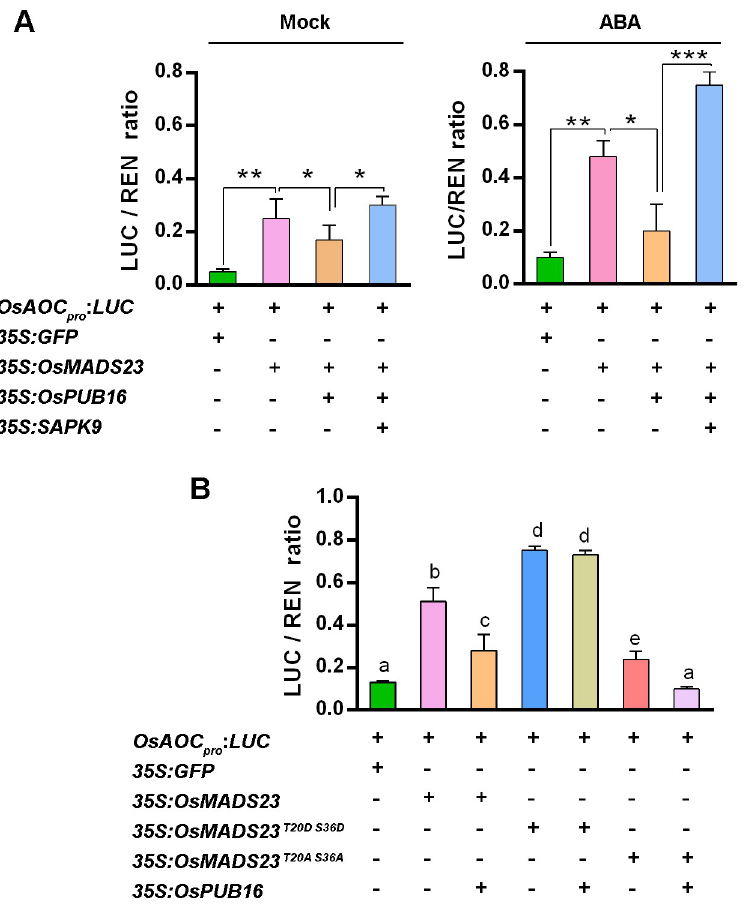
Fig 9. The influence of SAPK9 or OsPUB16 on the transcriptional activity of OsMADS23. (A) Luciferase transient transcriptional activity showing the influence of SAPK9, OsPUB16 or ABA on the transcriptional activity of OsMADS23. Luciferase transient transcriptional activity assay was performed in Nicotiana benthamiana leaves co- transfected with the reporter and different effector constructs. The transfected leaves treated with and without 50 μ M ABA for 2 hours were used. Data are means ± SD ( n = 3). The significant difference was determined by Student’s t test. � p < 0.05, �� p < 0.01 or ��� p < 0.001. ns, not significant. (B) Luciferase transient transcriptional activity showing OsMADS23 phosphorylation reducing the repression of its transcriptional activity mediated by OsPUB16. Data are means ± SD ( n = 3). Recombinant GST-OsMADS23 or its different mutated versions (GST-OsMADS23 T20A S36A and GST-OsMADS23 T20D S36D ) was used. Two-way ANOVA followed by Bonferroni’s post-hoc test was performed. Different letters with the same superscript mark indicate significant differences ( p < 0.05). The transient transactivation activity assays were performed in the leaves of N . benthamiana by agroinfiltration expression system.